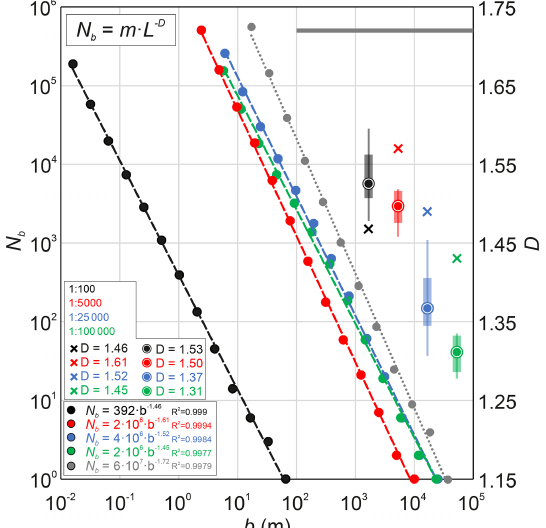
Figure 4. Results of the box-counting method applied to the lin- eament maps of Fig. 3. The dashed interpolation curves represent the results from box-counting analyses of the entire lineament maps for each scale of observation. The gray dotted curve represents the results of the box-counting analyses applied to the distribution of the exposed land surface in the Bømlo island archipelago. The solid gray line represents the value of D for the land surface ( D = 1 . 71). The box-and-whisker plot represents the distribution of the frac- tal dimension D obtained from the box-counting analyses of se- lected sub-areas of lineament maps for each scale of observation. Encircled dots represent the average value of D obtained from the analyses of sub-areas. The cross marker represents the fractal di- mension D obtained from the analysis of the entire lineament map (lineaments maps and selected sub-areas are reported in Fig. S1; the whole dataset is available at the online repository).